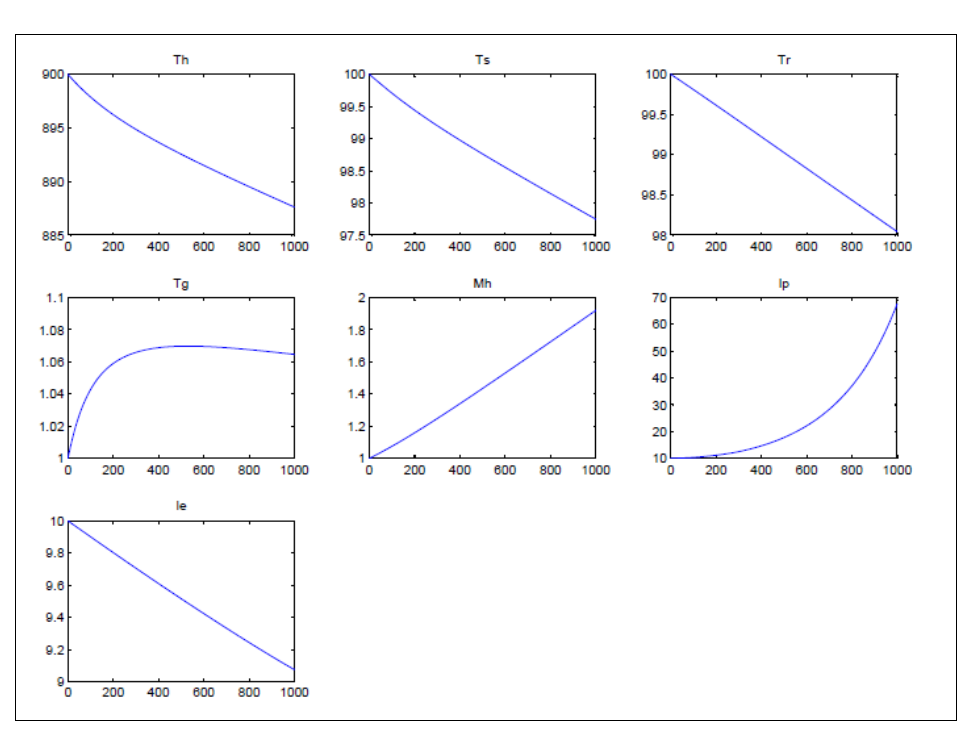
Figure 6. Lymphocytes, macrophage and CTL dynamics (nonconcave